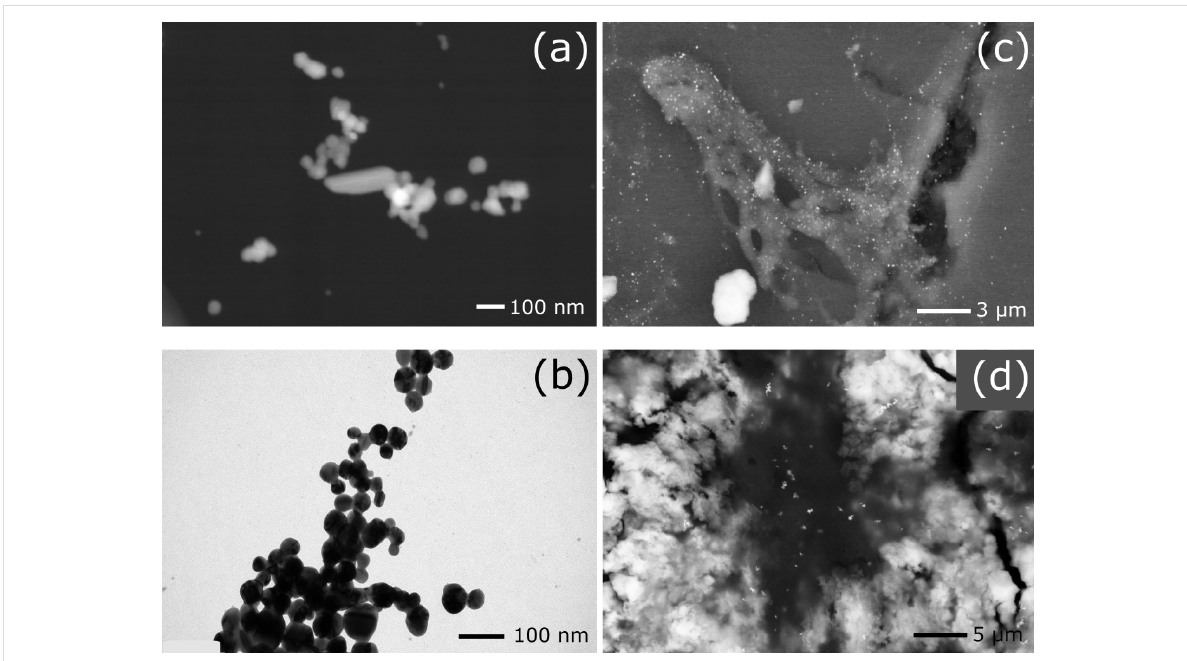
Figure 2: (a) Scanning electron microscopy (SEM) image of silver nanoparticles. The nanoparticles have a high degree of polydispersity in size ranging from 10 to 100 nm with an average size close to 50 nm. (b) Transmission electron microscopy image of silver nanoparticles showing their pre- dominantly spherical shape and polydispersity in size. (c) SEM image of intact cells mixed with nanoparticles showing the distribution of nanoparticles on the surface of the cell. (d) SEM image of cell lysate mixed with nanoparticles showing released cellular biomolecules with nanoparticles after disruption of cell membrane.